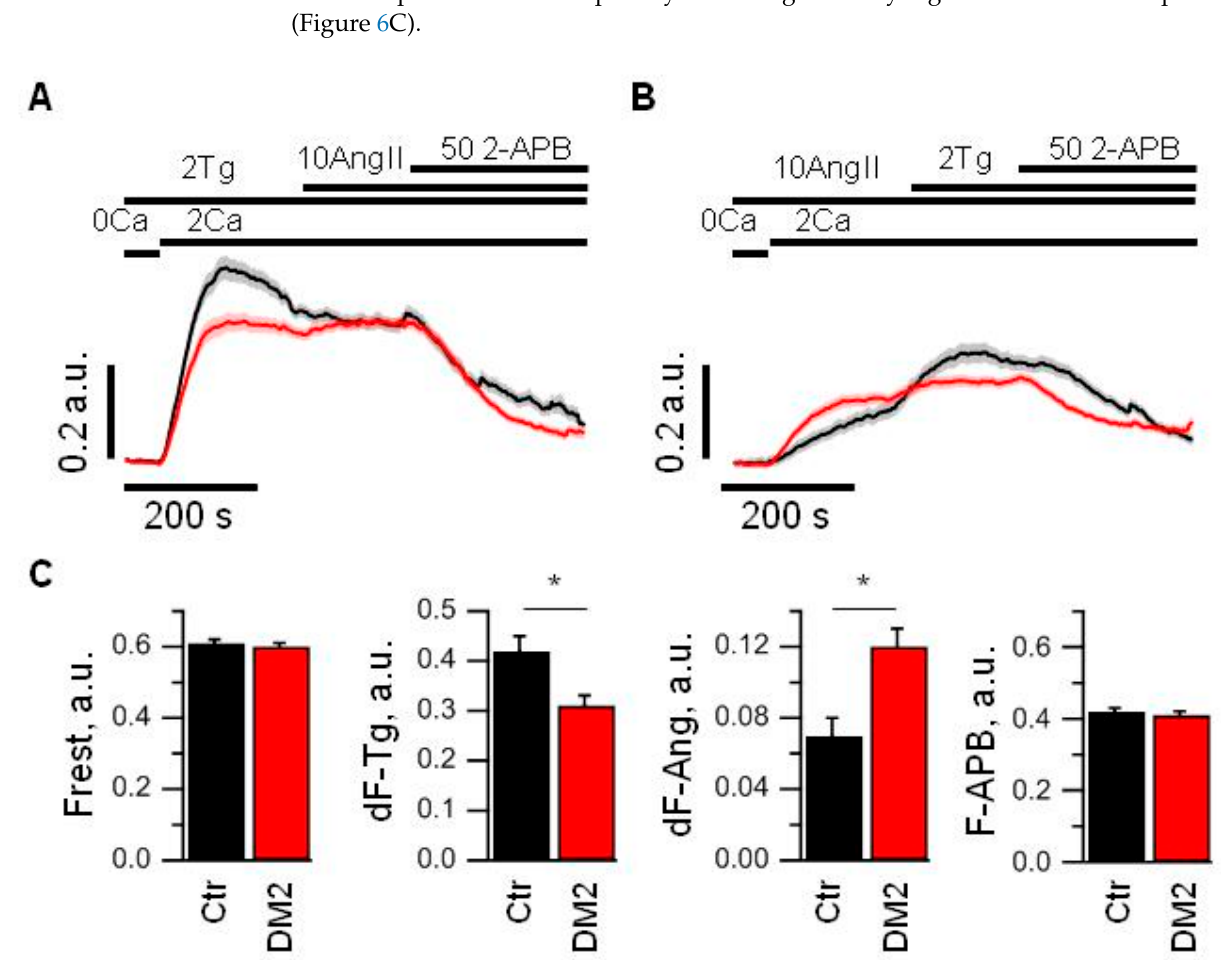
Figure 6. Store-operated Ca 2+ entry is decreased and receptor-activated Ca 2+ entry is increased in glomerular podocytes from diabetic rats. ( A , B ) An averaged ratio of fura-2 fluorescence at 340 and 380 nm, which reflect changes in intracellular Ca 2+ concentration in control (black) and diabetic (red) podocytes. Podocytes were stimulated with 2 µ M Tg or 10 µ M Ang II for 4 min in 0 mM Ca 2+ solution prior to 2 mM Ca 2+ addition. The bars above the graph indicate the time when 0 or 2 mM Ca 2+ was used, when 2 µ M Tg, 10 µ M Ang II or 50 µ M 2-APB were added. ( C ) Bar plots summarizing the analyzed parameters from control (Ctr, black) and diabetic (DM2, red) groups measured from the data shown in panel A and B. Indicated are resting fluorescence ratio (Frest, which reflects the basal level of [Ca 2+ ] i ), an averaged amplitude of Tg-induced Ca 2+ entry (dF-Tg, measured from experiments shown in panel A), an averaged amplitude of Ang II-induced Ca 2+ entry (dF-Ang, measured from experiments shown in panel B), and averaged fluorescence obtained after application of 50 µ M 2-APB (F-APB, measured from experiments shown in panel A). Data were analyzed by Mann–Whitney test. * indicate p values of